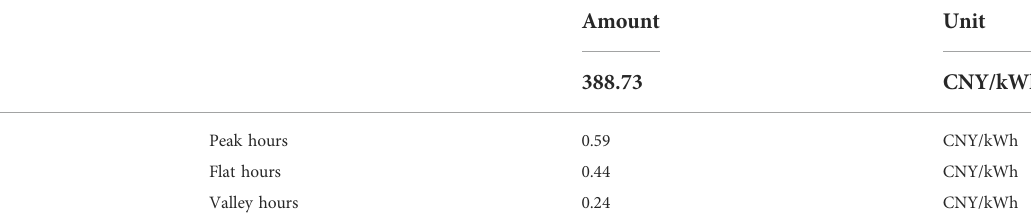
TABLE 4 Scheme of double-stage